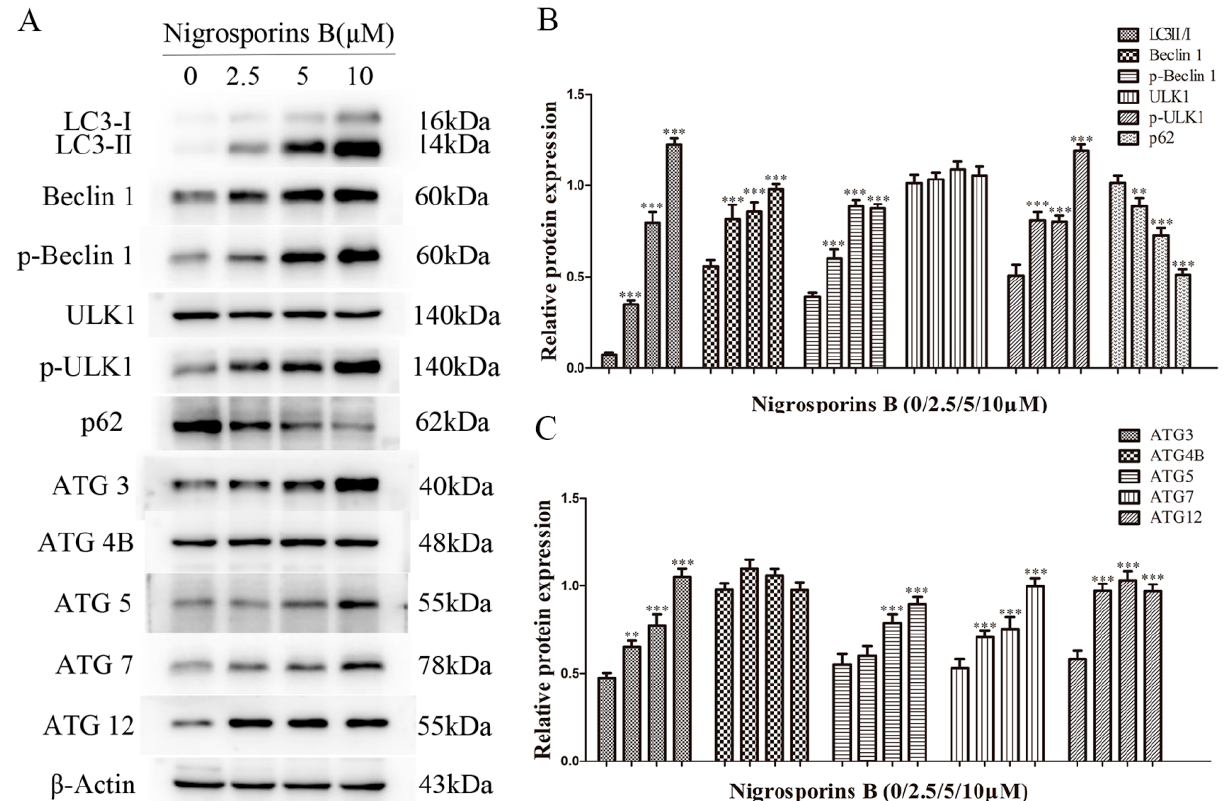
Figure 8. Nigrosporins B affected the expression of autophagy-related proteins in Ca Ski cells, cells were treated with Nigrosporins B for 24 h. ( A ) Representative western blotting bands of LC3-II/LC3- I, Beclin-1, p-Beclin-1, ULK1, p-ULK1, p62, ATG3, ATG4B, ATG5, ATG7 and ATG12; ( B ) and ( C ) Protein expression of LC3 II/I, Beclin-1, p-Beclin-1, ULK1, p-ULK1, p62, ATG3, ATG4B, ATG5, ATG7 and ATG12 (** p < 0.01, *** p < 0.001).